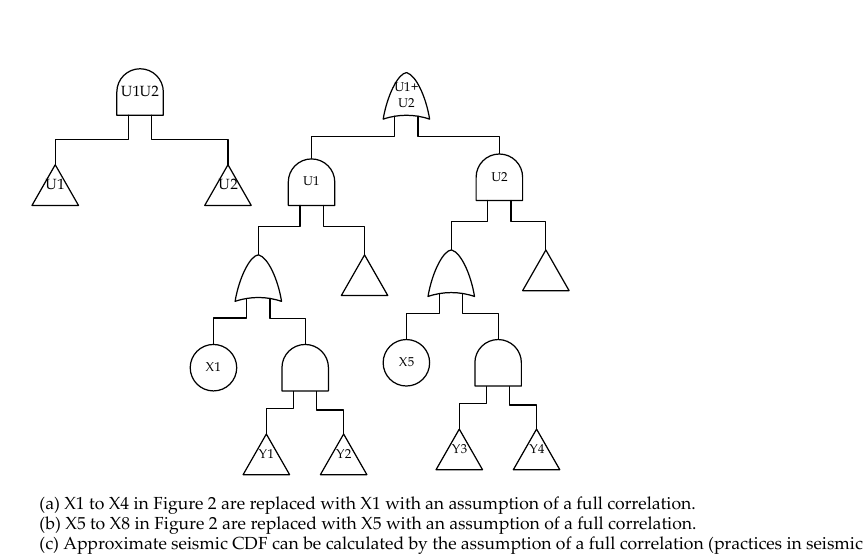
Figure 4. MUCDF and SDF fault trees simplified by the full correlation assumption (Model B).